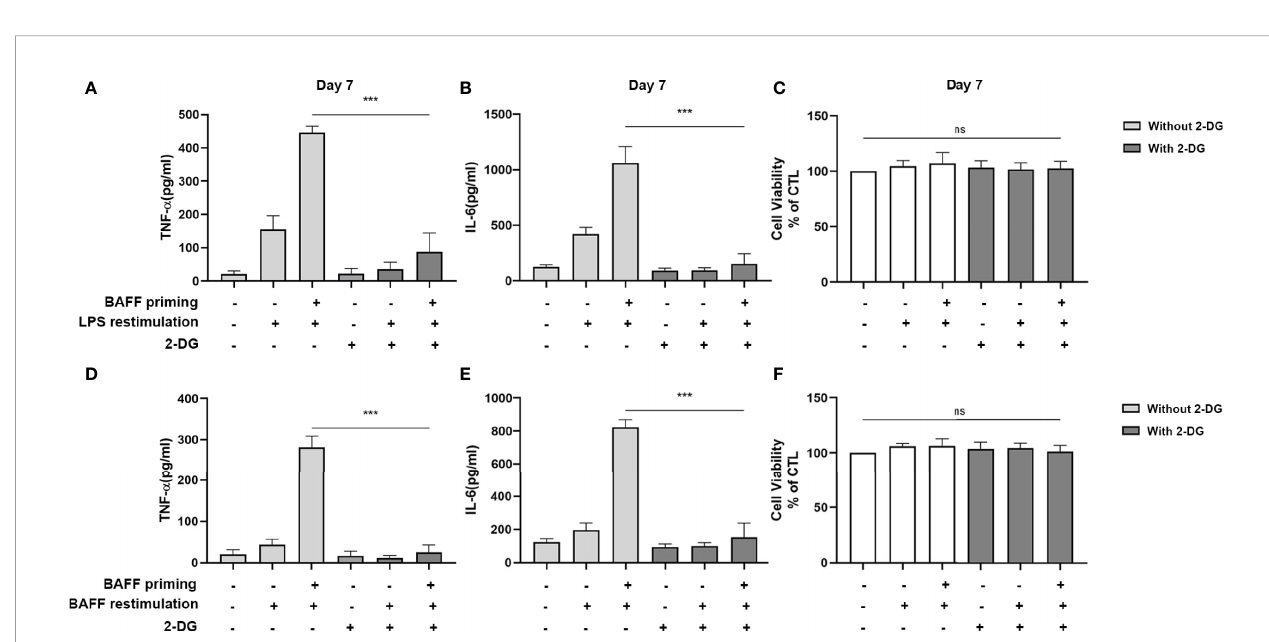
FIGURE 3 | Inhibition of glycolysis by 2-DG blocked proin fl ammatory cytokines secretion of BAFF-training BV2 cells. BV2 cells were pretreated with 1mM 2-DG for 1 h, then primed with vehicle or BAFF for 24 h. After a rested of 5 days, cells were restimulated with LPS or BAFF for 24 h. The amounts of TNF- a (A) and IL-6 (B) were measured in the culture supernatants and the cytotoxicity of 2-DG was measured by MTT (C) on day 7 upon LPS restimulation (n = 12). The secretion of TNF- a (D) and IL-6 (E) and the cytotoxicity of 2-DG (F) were measured on day 7 upon BAFF restimulation (n = 12). The Data are mean ± SEM; Kruskal-Wallis test with Turkey post hoc test; ***p < 0.001. ns: no signi fi cance between